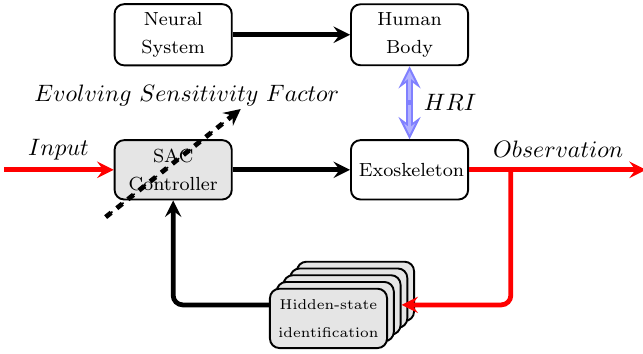
Figure 1. Proposed control framework. In the feedforward control loop, the sensitivity amplification control (SAC) controller with the evolving sensitivity factor (in black dashed arrow) provides the necessary driven torque according to the variational HRI (human-robot interaction, given in double blue arrows). Moreover, to improve the control performance, the hidden-states are identified in the feedback control loop according to the observation information. Note that, the red color arrows stand for input and output, while the black arrows present the signal direction.